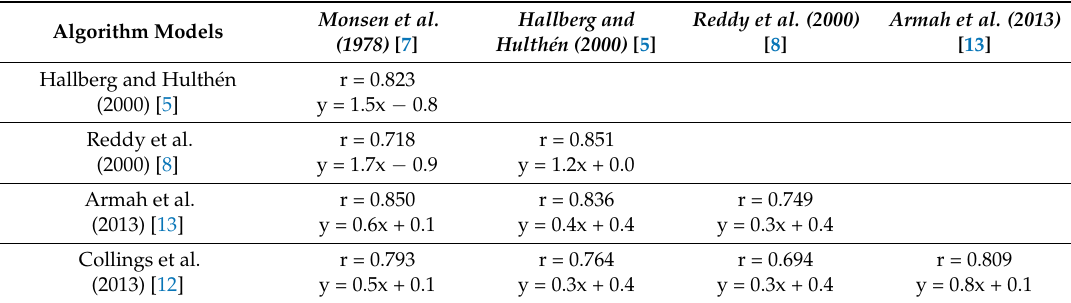
Table 4. Correlation coefficients and simple linear regression equations of the bivariate relationship between iron bioavailability estimates